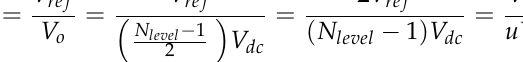
Table 9. Output voltage level status under healthy, faulty, and post-fault conditions. Faulty Switch(es)